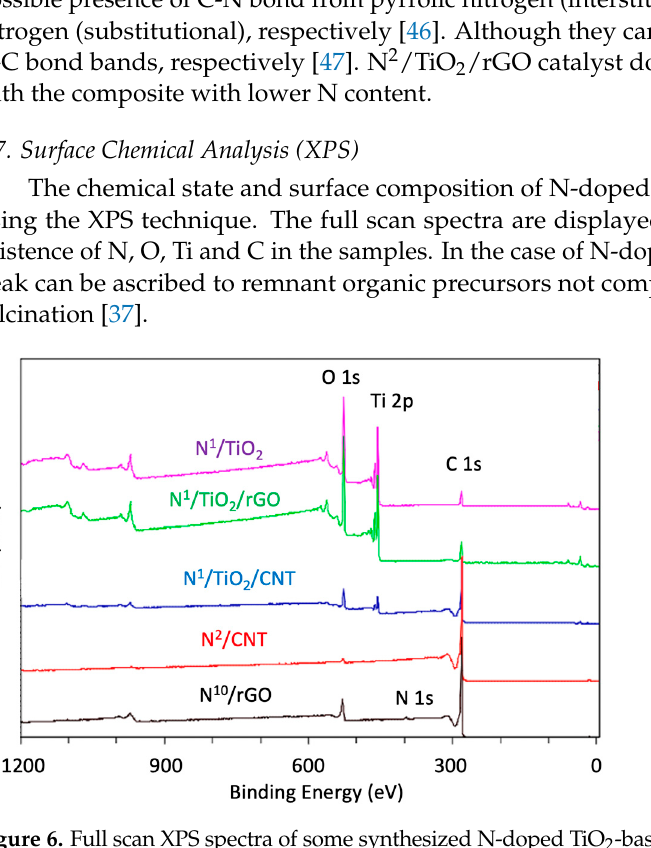
Figure 6. Full scan XPS spectra of some synthesized N-doped TiO 2 -based photocatalysts and supports.